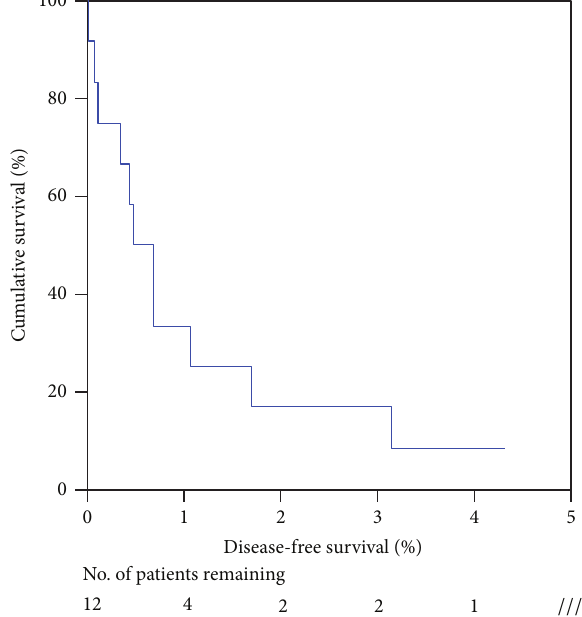
Figure 2: Disease-free survival of NELM patient after